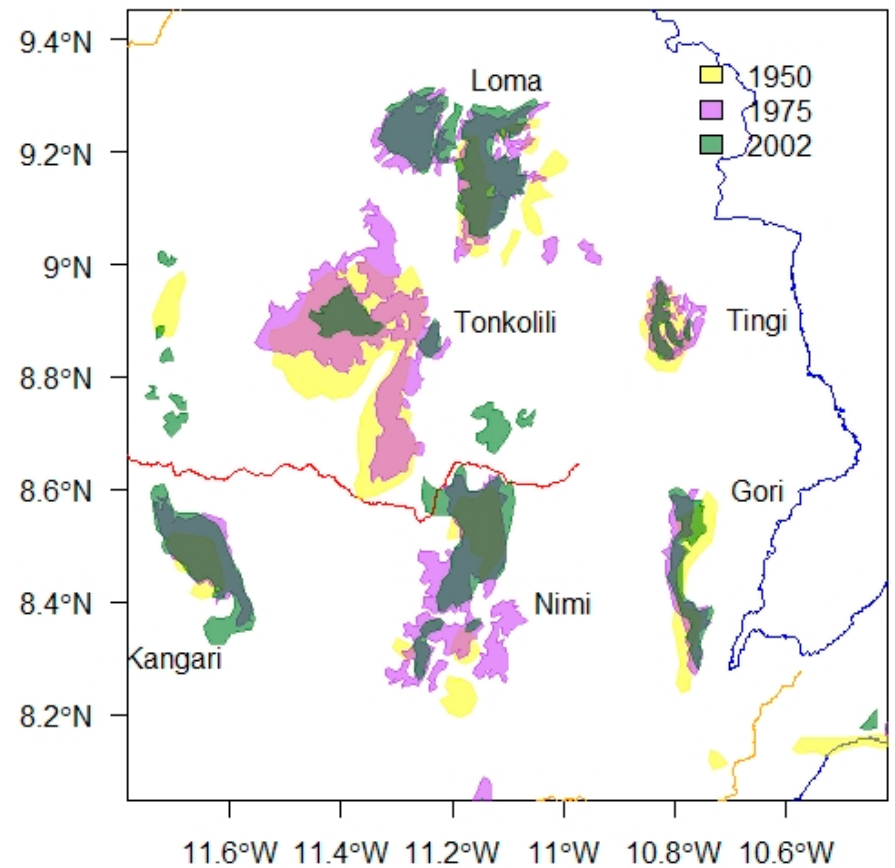
Figure 6. Forests of Central Sierra Leone showing the reduced area of forests of Tonkolili.